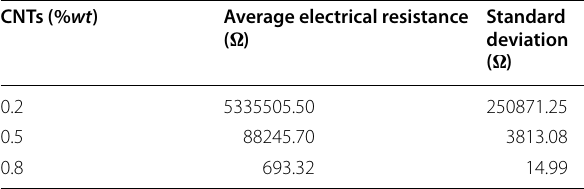
Table 1 Electrical resistance values and their corresponding standard deviations obtained from the I–V curves characterization.